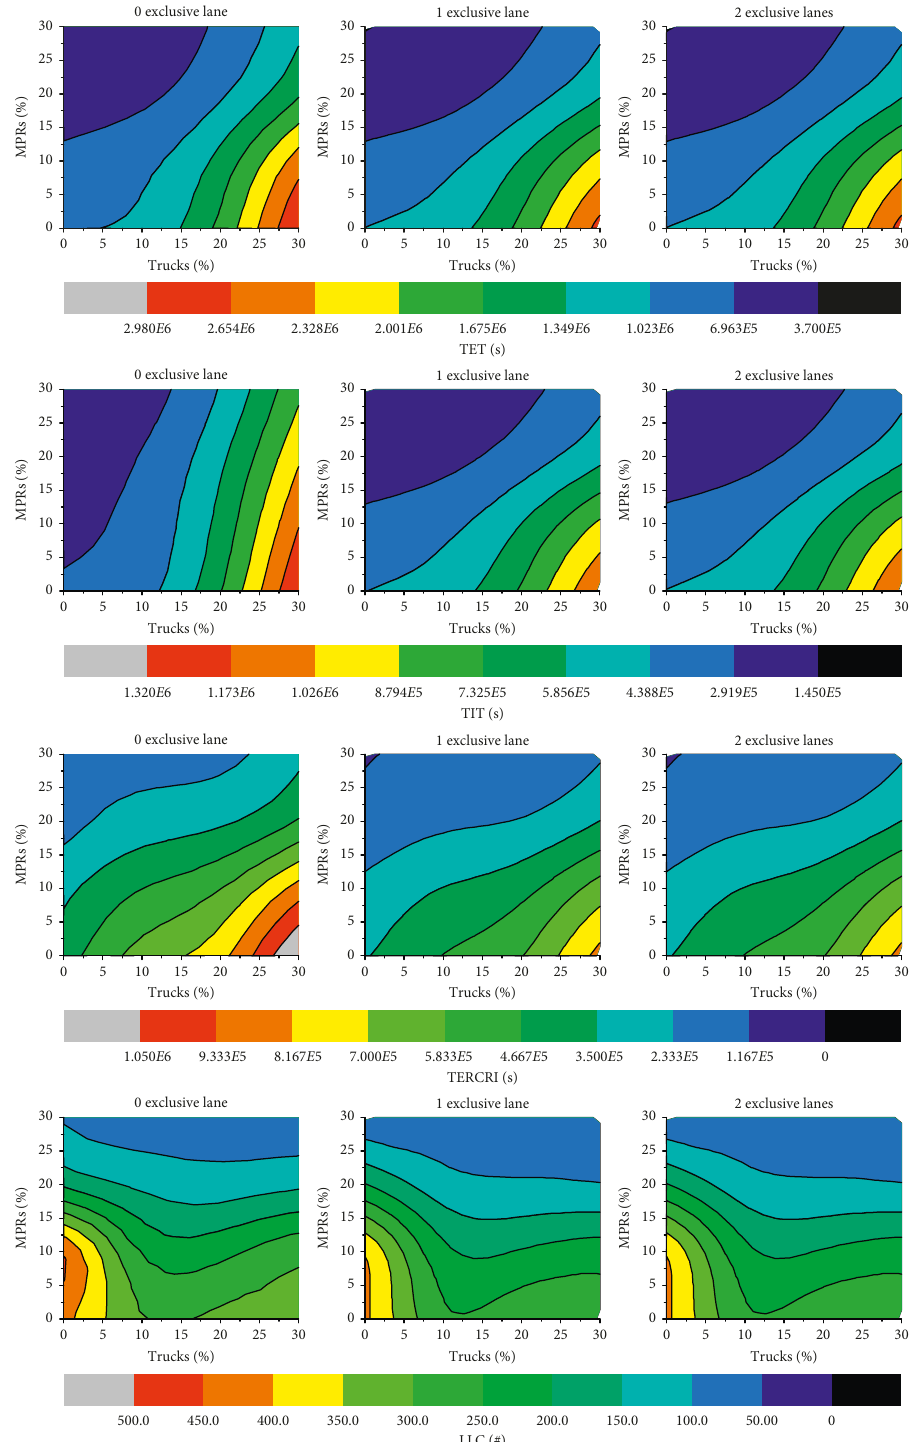
Figure 5: Safety evaluation results of CAV’s exclusive lane on volume � For all situations, we found that, with the increase of TET and LCC on MPRs � 10% and 20% is presented in truck proportion, longitudinal safety risk indexes (e.g., Figure 8. Finally, an overall longitudinal and lateral safety TET, TIT, and TERCRI) are at a rise in all scenarios, impact comparison of setting exclusive lane scenarios to- indicating that heterogeneity of traffic composition ward the base scenario is shown in Table 4.